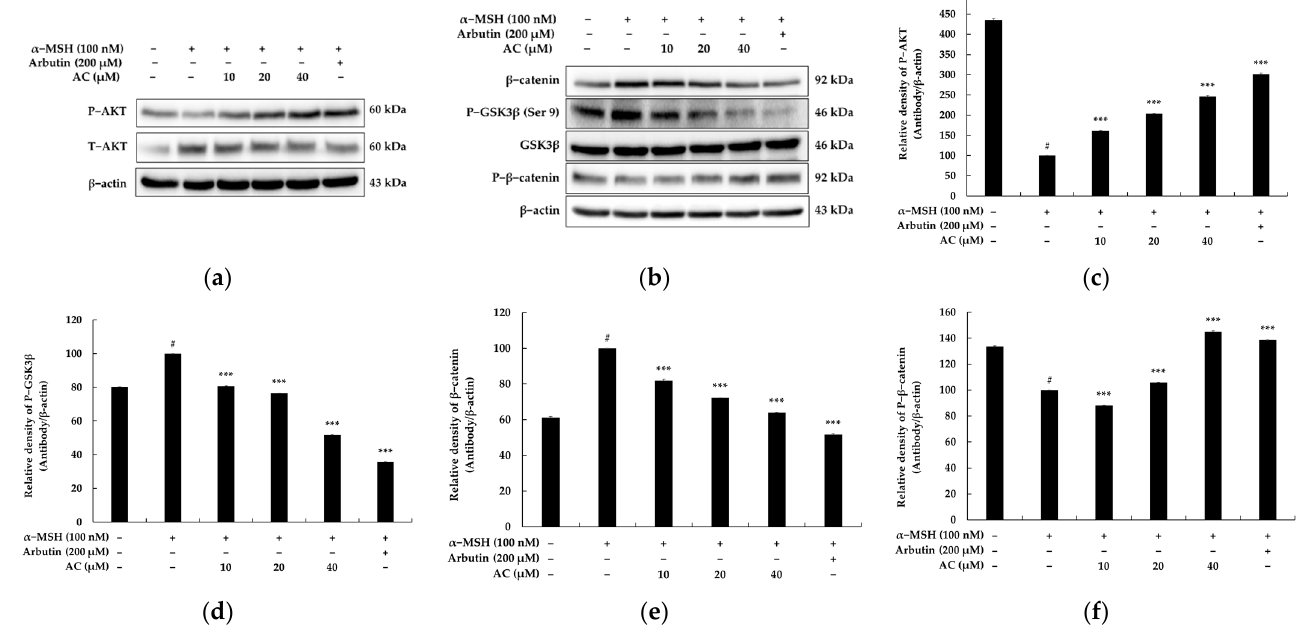
Figure 6. The e ff ect of acenocoumarol on AKT, P − GSK3 β , β− catenin, and P −β− catenin protein expression in α− MSH-stimulated B16F10 cells. α− MSH was used as the negative control and arbutin (200 μ M) was used as the positive control. ( a , b ) Protein expression levels of AKT, P-AKT, GSK3 β , P − GSK3 β , β− catenin, and P −β− catenin were determined by Western blot following with acenocoumarol (10, 20 and 40 μ M) treatment for 4 h in the presence of α− MSH (100 nM). The densitometric analysis of P-AKT ( c ), GSK3 β ( d ), β− catenin ( e ), and P −β− catenin ( f ) using Image J and present the results as mean ± SD. Statistical significance was expressed as follows: # p < 0.001 vs. unstimulated control group, *** p < 0.001 vs. α− MSH alone.